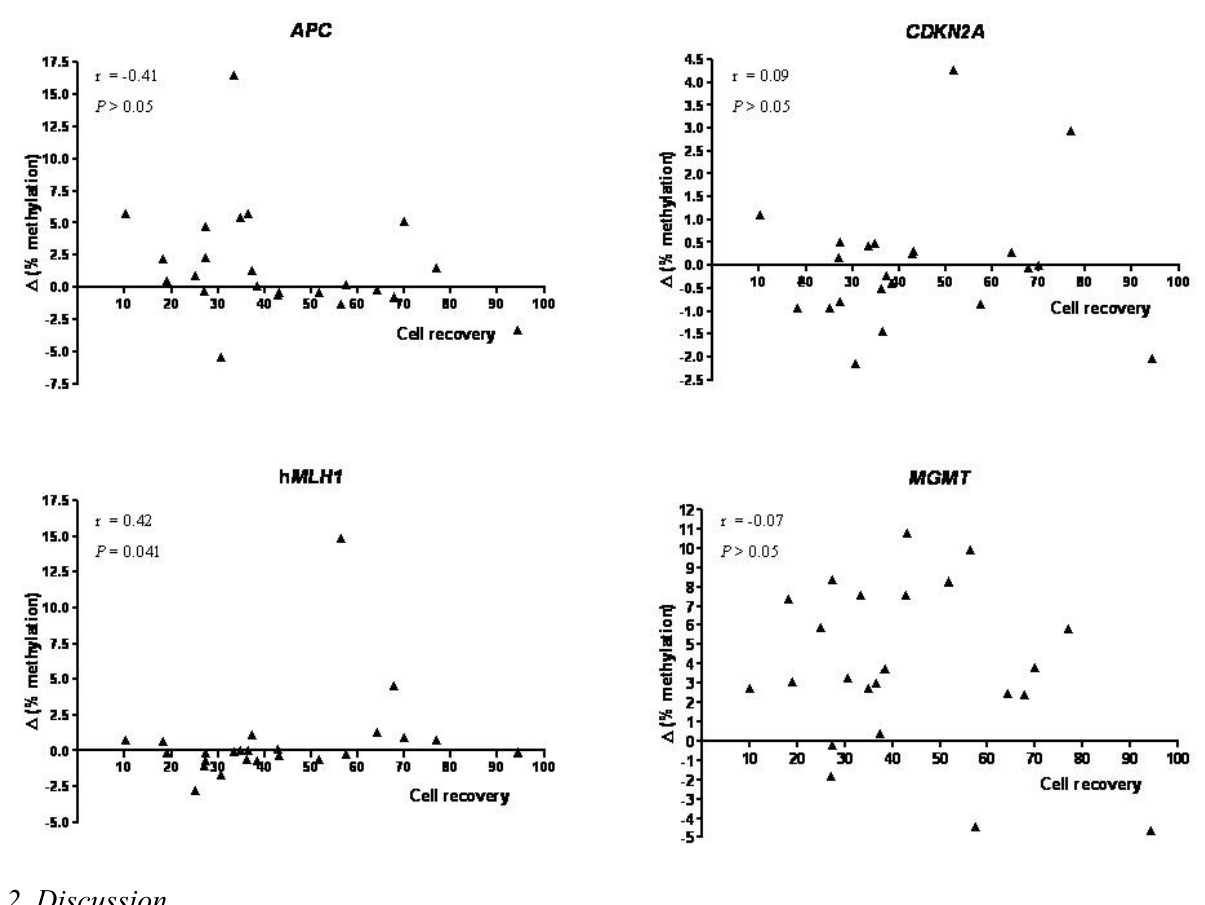
Figure 3. Correlation between cell recovery and values obtained by the difference in DNA methylation between the enriched and non-enriched cell fractions. Tumor cell recovery ( X axis) was obtained by the ratio between the EpCAM positive fraction and the whole tumor sample. Δ methylation ( Y axis) represents the values obtained by the difference in average percent methylation for all CpG loci analyzed between the EpCAM-enriched and non-enriched samples. Spearman’s correlation coefficients and p -values are